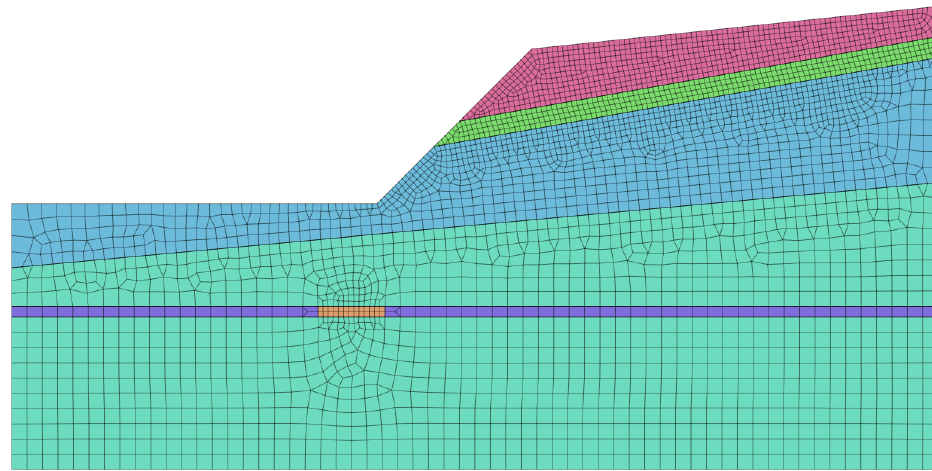
Figure 4. Meshing of the finite element model.